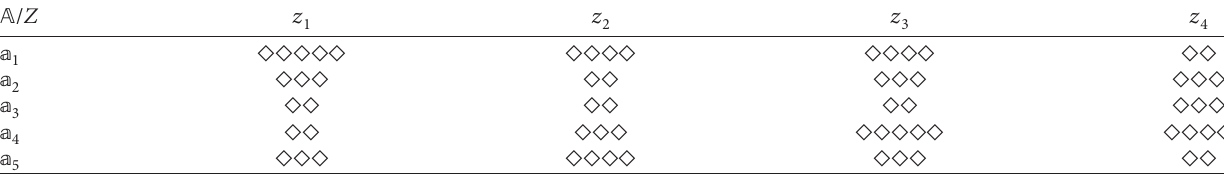
Table 20: Evaluation of data from the